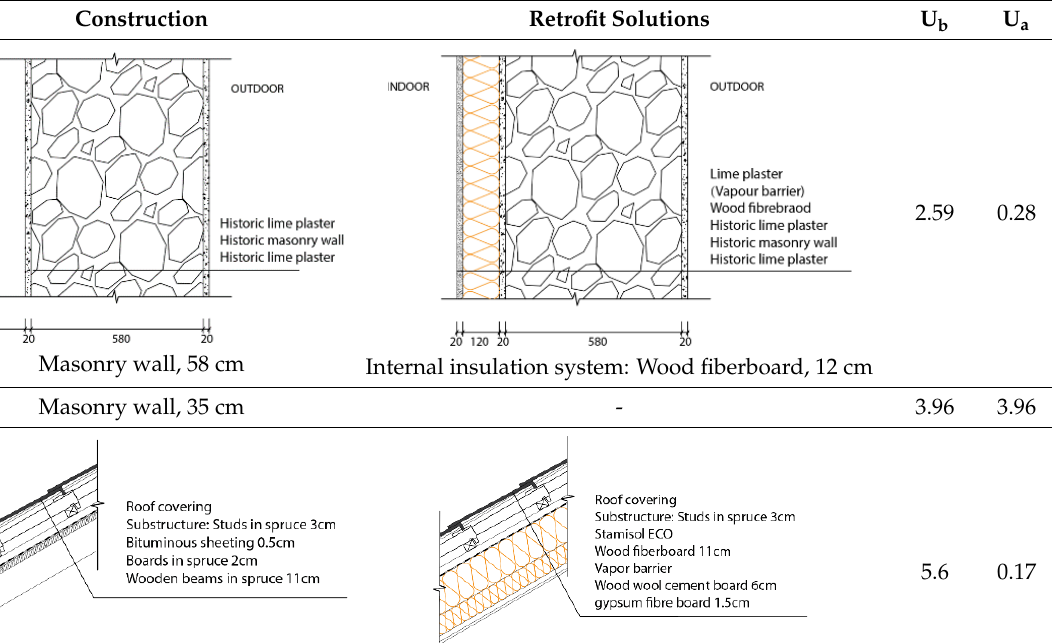
Figure 4. Architectural layout ( a ) and photograph ( b ) of the Portici house in Climate zone II. Table 4. Construction characteristics of the reference buildings. U b = U-value before retrofit (W/m 2 K); U a = U-value after retrofit. W/m 2 K).